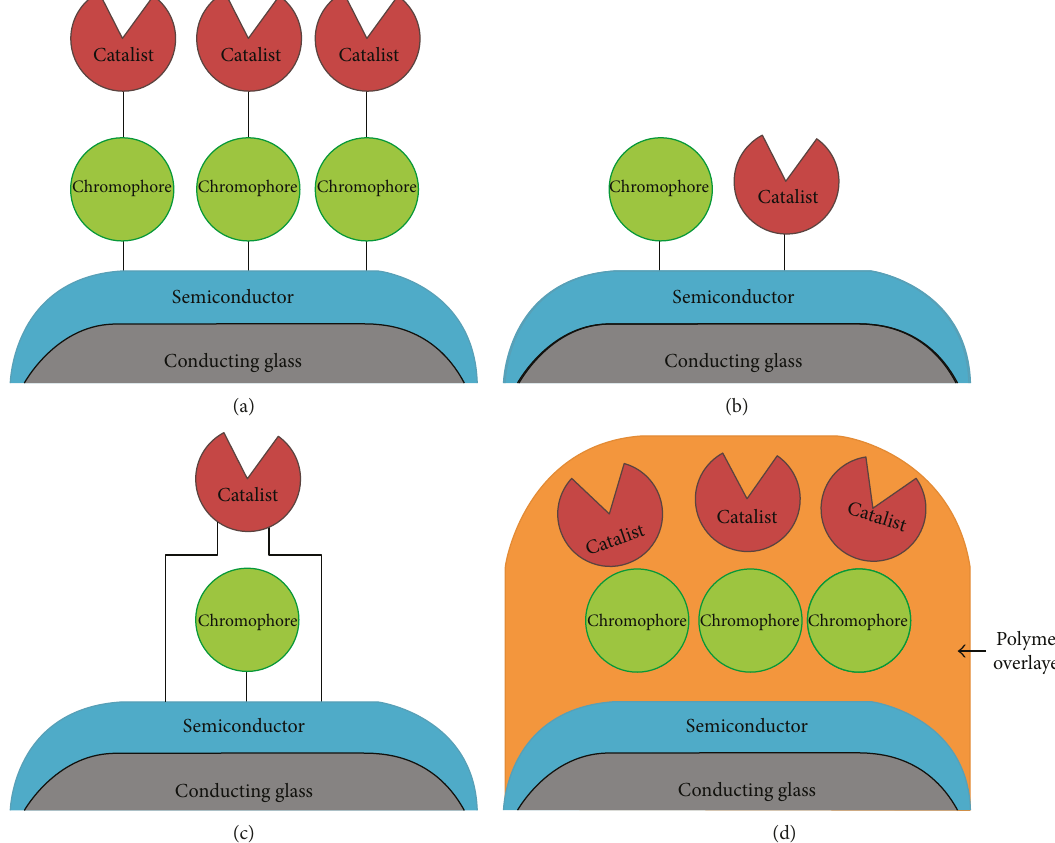
Figure 3: Some general schemes of photoanode architectures with (a) molecular assemblies, (b) coloading strategy, (c) molecular overlayer, and (d) polymer